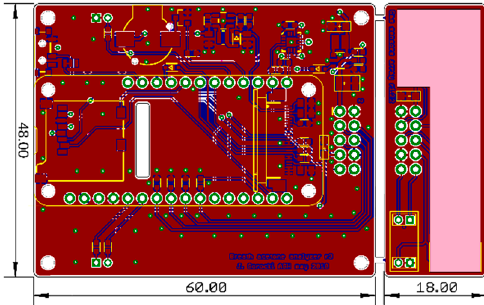
Figure 3. The layout of the motherboard and daughterboard PCBs. Dimensions in mm. Sensing array’s layout visibility is limited due to the patent pending.